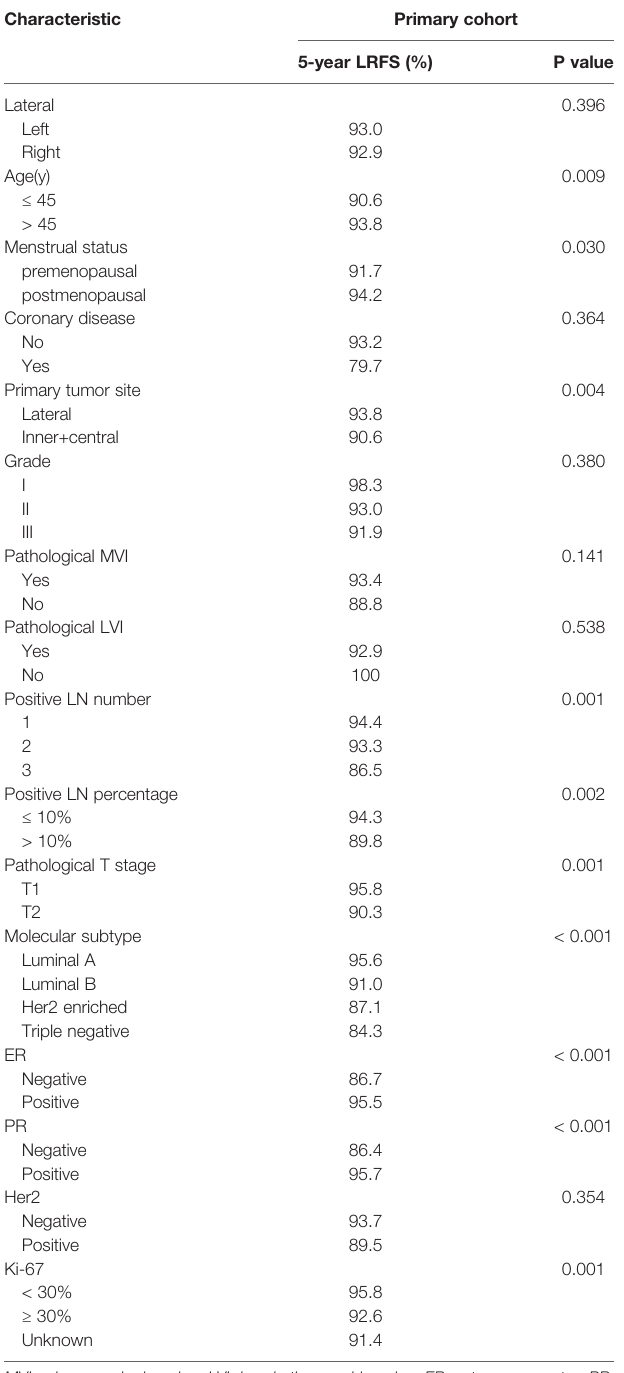
TABLE 3 | Multivariate analysis of the association between clinicopathological features and locoregional recurrence-free survival (LRFS) for patients with pT1N1M0 breast cancer in the primary cohort.